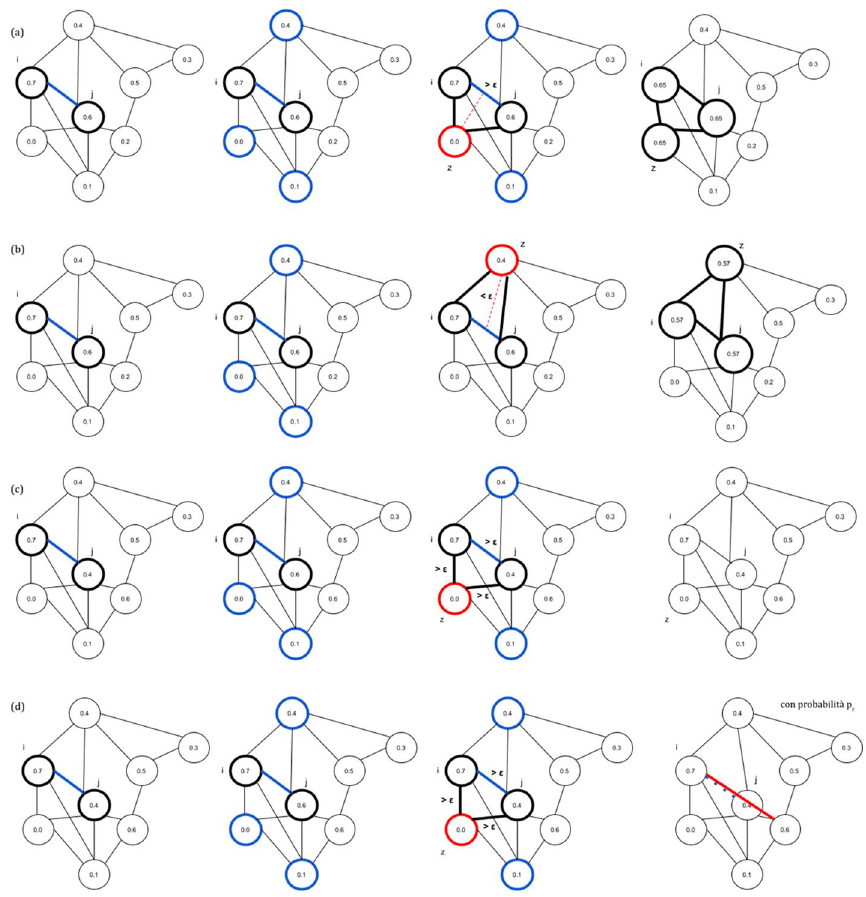
Fig. 2 Example of the AABSC model. Examples of different cases in the Adaptive Algorithmic Bias Model on Simplicial Complexes. In a , a triangle ( i , j , z ) is chosen, and the minority node adopts the mean opinion of the majority. In b , there is no minority, so the three agents adopt their average opinion. In c , there is no majority: nothing happens. In d , there is no majority, and agent i rewires the discording arc with j towards a more like-minded agent. The process in d is the same described in Fig.